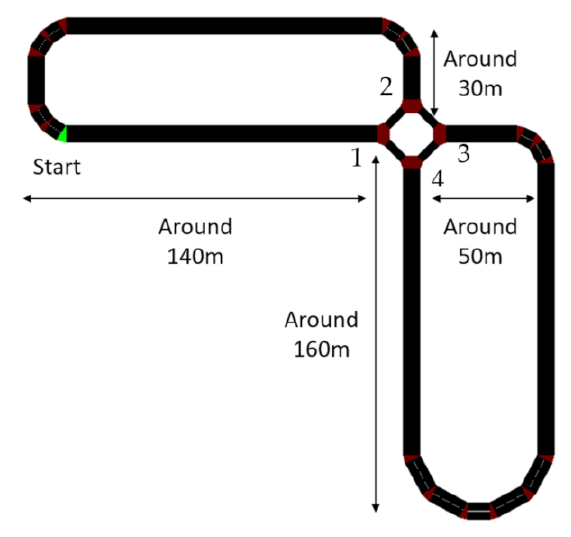
Figure 4. Sketch map of the